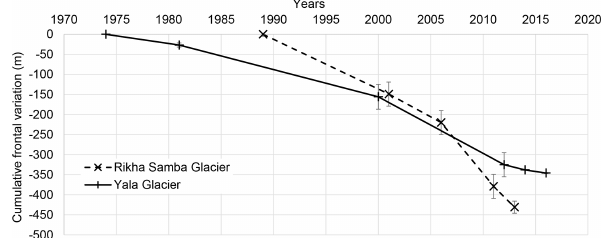
Figure 10. Cumulative glacier retreat of Yala and Rikha Samba glaciers, with uncertainty